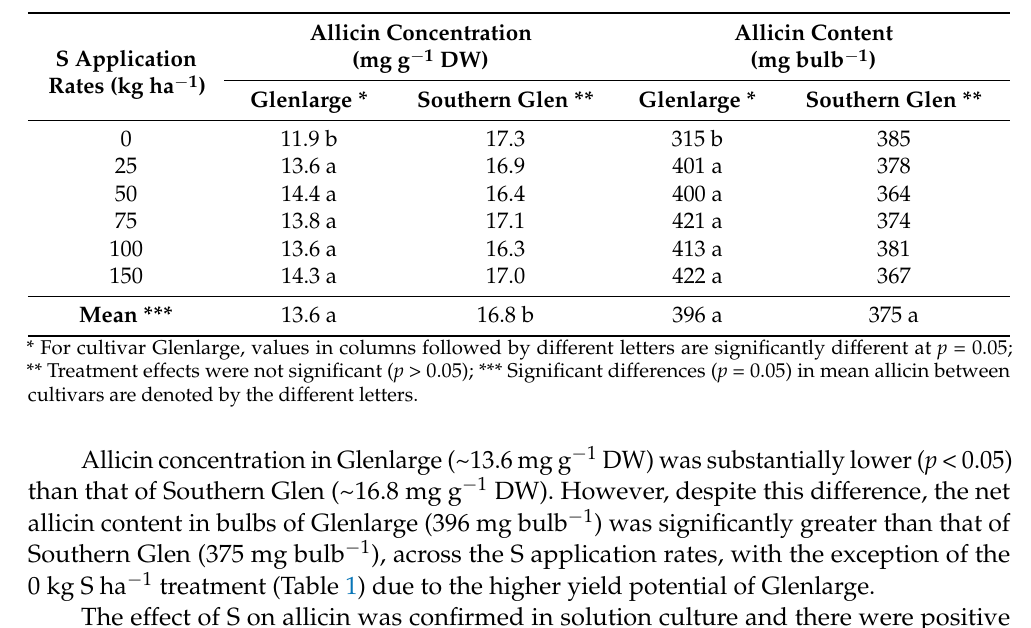
Table 1. Effect of sulfur application rate (0–150 kg ha − 1 ) on allicin concentration and allicin content in garlic bulbs of cultivars Glenlarge and Southern Glen grown under field conditions.